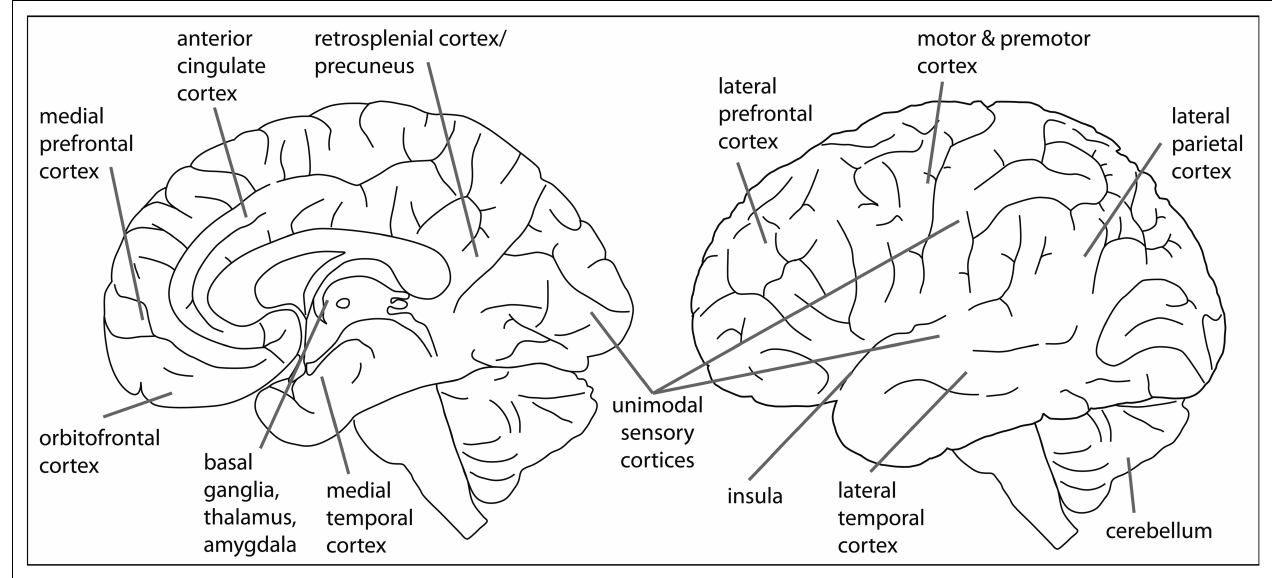
simplifi ed as it lacks both anatomical and functional specifi city. Nevertheless, it may be useful as an illustration and an invitation to further elaborate specifi c roles of the marked